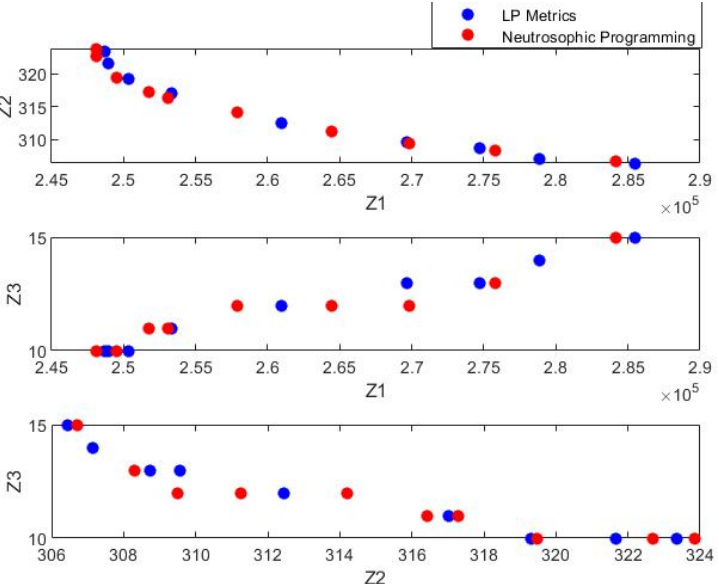
Figure 2. Comparison of the Pareto front of problem-solving at an uncertainty rate of 0.5.